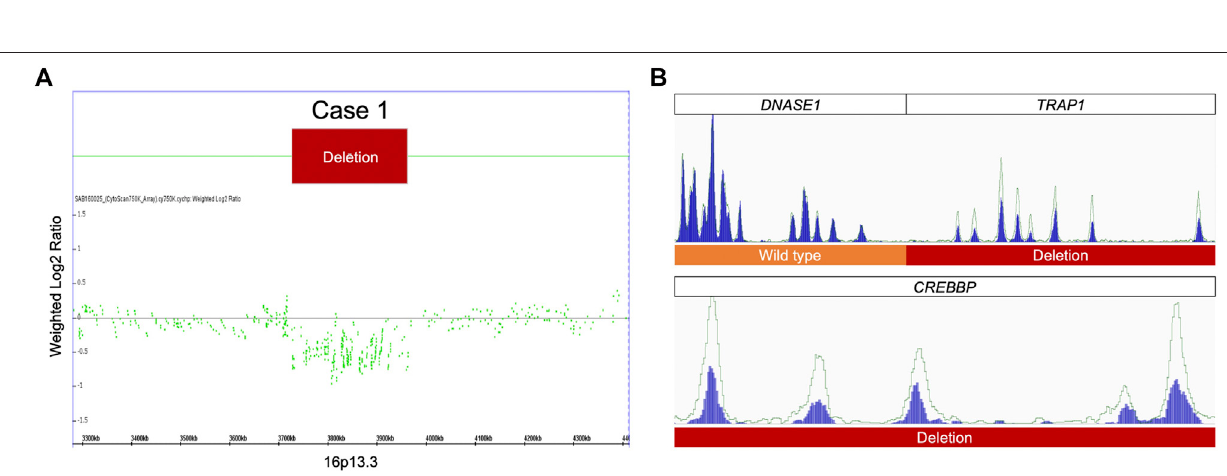
Frontiers in Genetics |